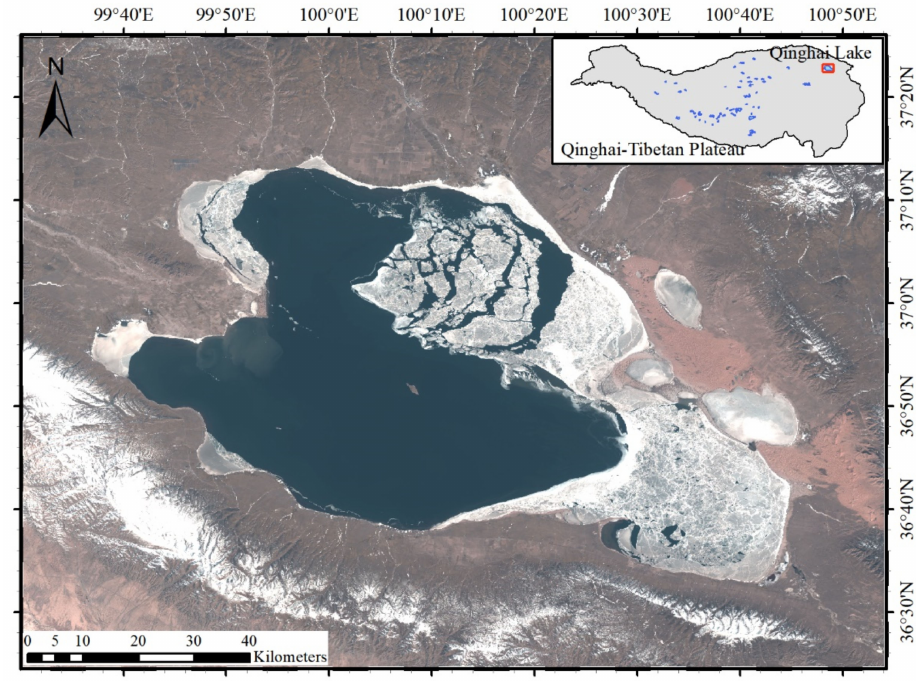
Figure 1. Location of Qinghai Lake (Landsat 8 image in 26 March 2017) and the lakes identified from the World Wildlife Fund’s Global Lake and Wetland Database (GLWD) level 1 products the Qinghai-Tibetan Plateau. Table 1. The information of the MODIS former seven bands [50] (* MOD09GQ version 6: Terra